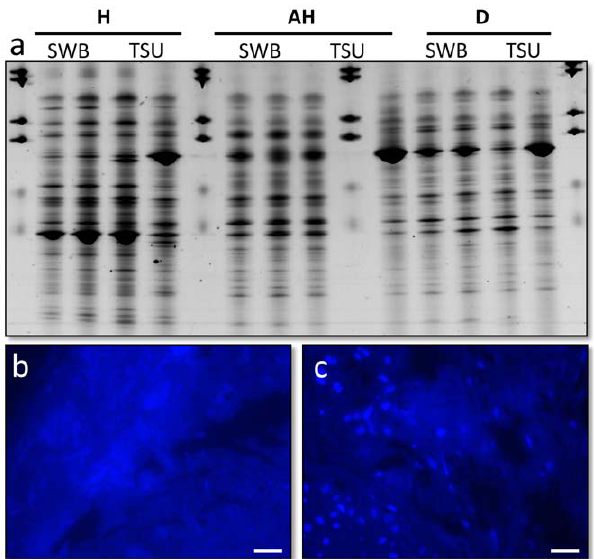
Figure 3. Microscopic images of Plectropomusleopardus tissues; a) Scanning Electron Micrograph (SEM) of the healthy tissue; b) SEM of the lesion. MGC=mucus goblet cells, M=mucus. c) Light microscope image of a healthy scale and d) light microscope image of a diseased scale, showing disorganisation of natural melanin patterns seen in (c). Scales bars=10 m m.